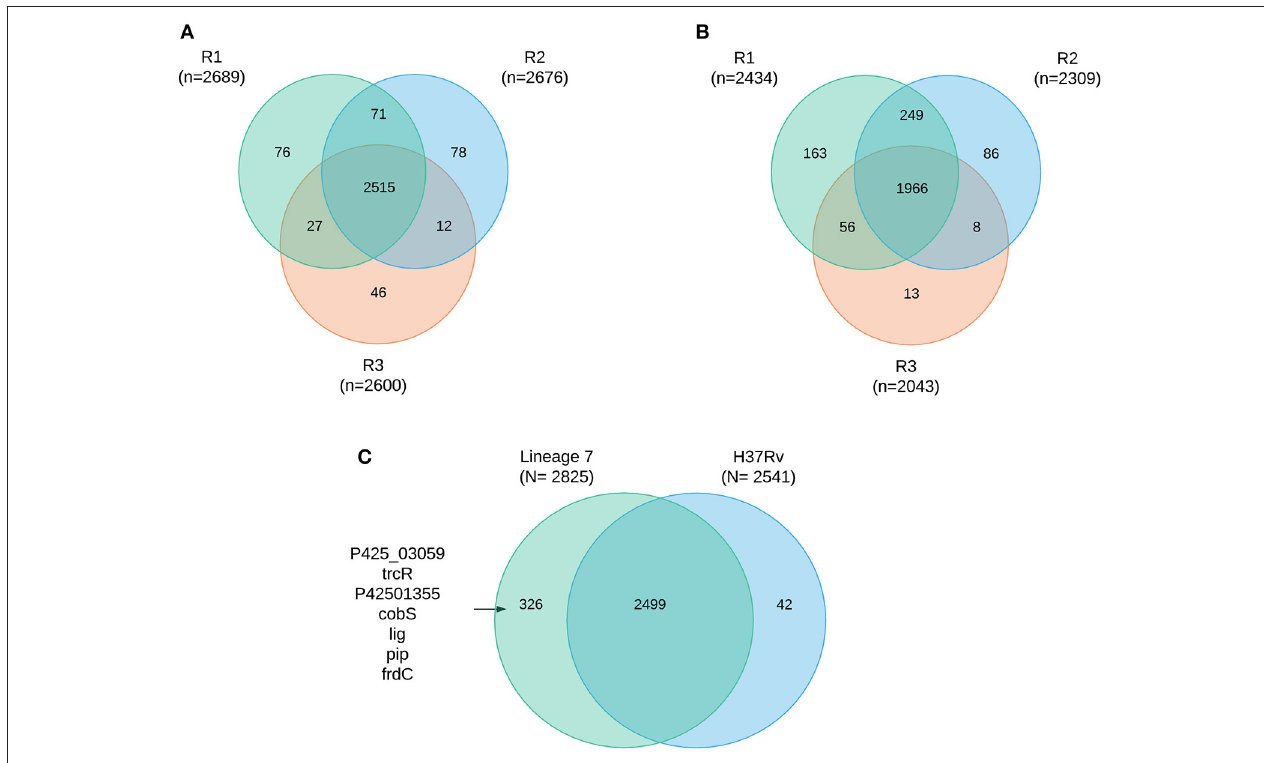
FIGURE 1 | Protein coverage Venn plot illustrating protein identification overlaps among the three biological replicates (R1–R3) in M. tuberculosis lineage 7 (A) and in lineage 4 (B) isolates, (C) overlap of protein identification between lineages and some of the mutually exclusively identified